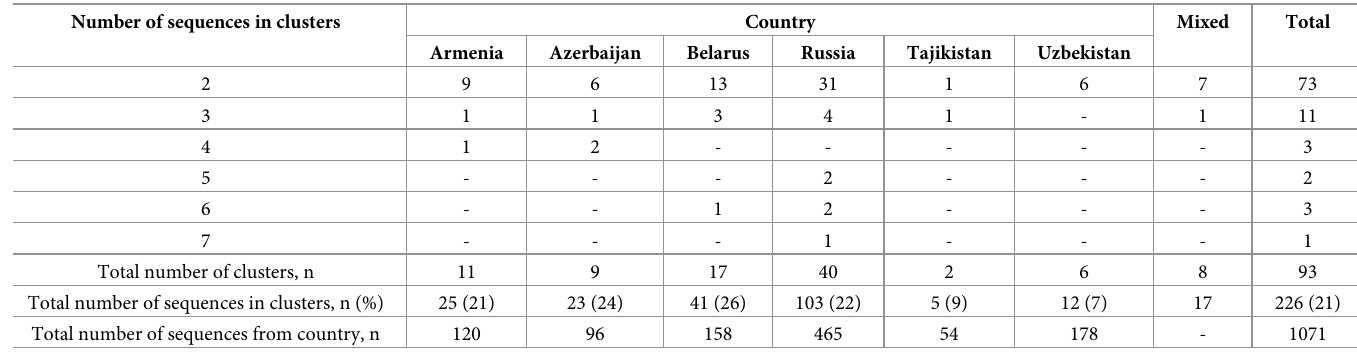
Table 5. Cluster characteristics by number, size and country.